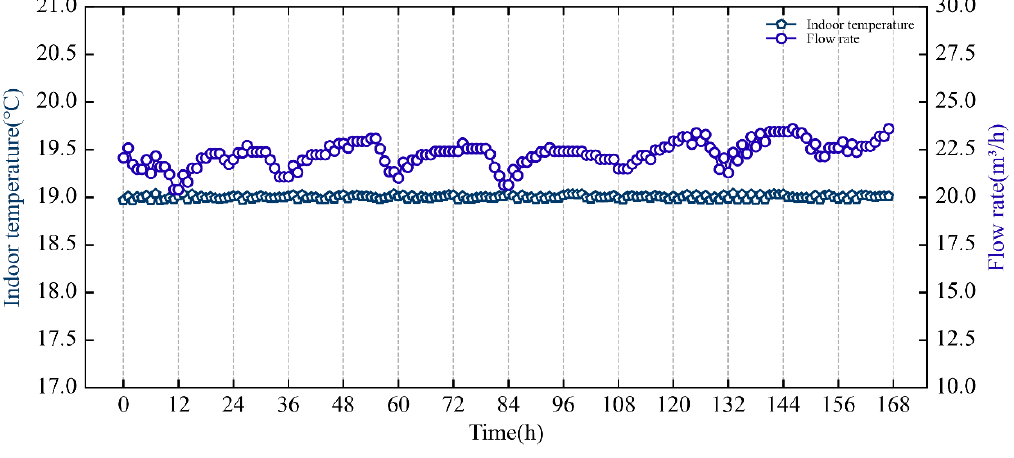
Figure 15. PID control effect in building B.